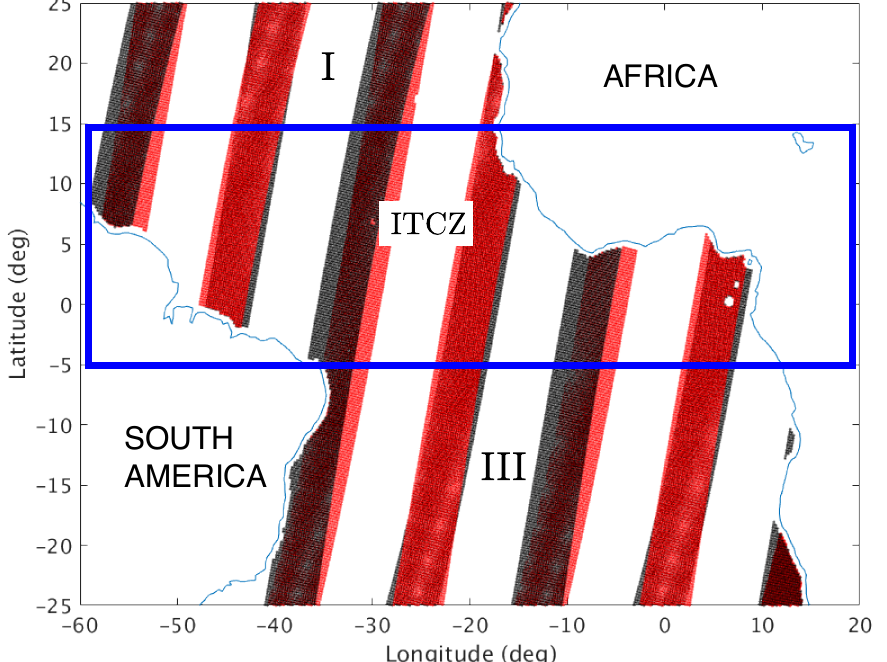
Figure 3. Overlapped portions of ASCAT-A (red) and -B (black) swaths over Tropical Atlantic. Tropics are divided into three latitude bands. Main region of interest lies within rectangle, labeled ITCZ. Latitude band to its north is labeled Region I, and to its south, Region III. In the tropics, half of the time the right swath of ASCAT-A overlaps the left swath of ASCAT-B and vice versa. The left edge of the later scatterometer is shifted slightly eastward relative to the earlier scatterometer. To distinguish the time-of-arrival, the scatterometers are re-labeled SCAT-1 and SCAT-2. In the figure, the SCAT-2 swath overlies the SCAT-1 swath.